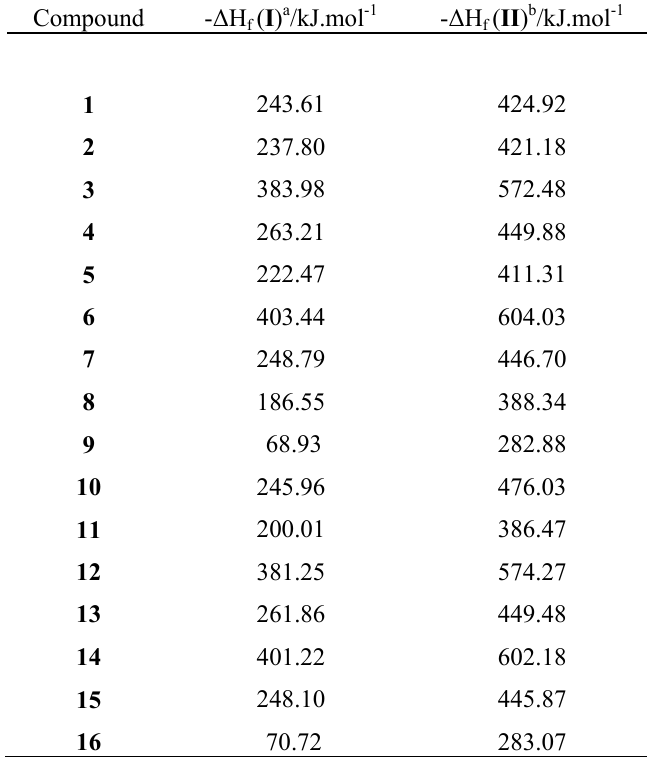
Table 3. Calculated PM3 heats of formation for substituted N